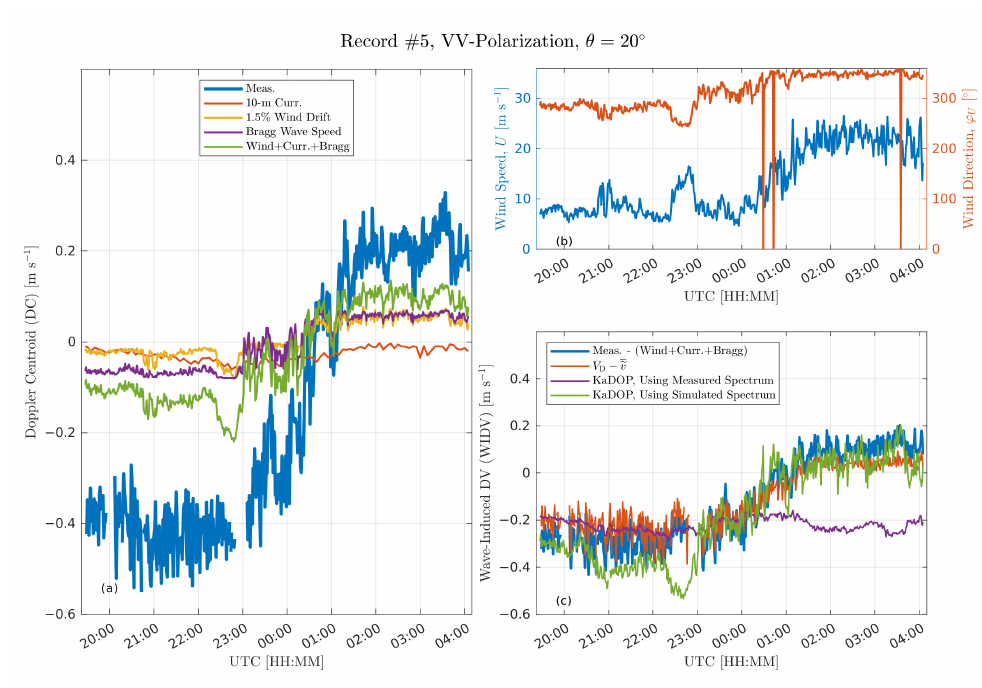
Figure 11. Data from Record #5 at θ = 20 ◦ (24–25 October 2018, see also Figure 2). Time series of 1 min average: ( a ) Doppler centroid (DC) and its contribution due to currents, wind, and Bragg scattering; ( b ) wind speed and wind direction; and ( c ) wave-induced Doppler velocity (WIDV) estimated in different ways: ( blue )—measurements; ( reddish )—wave resolving Doppler radar measurements; ( purple )—KaDOP based on wave gauge array measured wave spectrum and Equation (11); ( green )— KaDOP based on simulated wave spectrum combining wave gauge array measured wave spectrum with wind-based JONSWAP parametrization for high frequency ( f > 0.3 Hz) part and Equation (11).